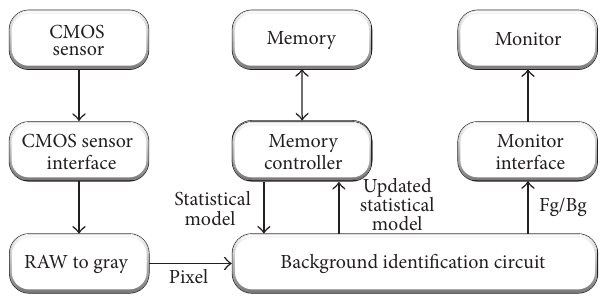
Figure 1: Conceptual overview of a background identification sys-